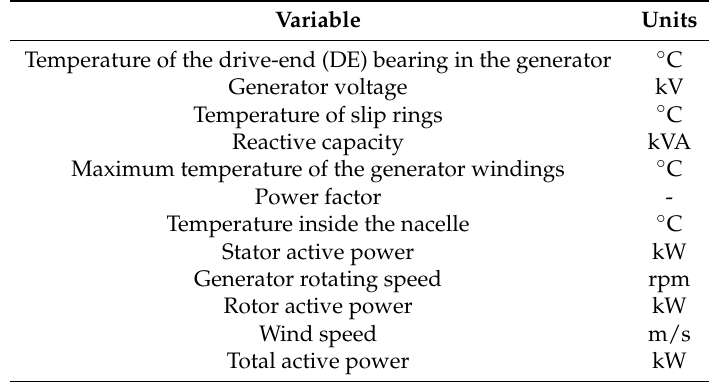
Table 1. Variables of the wind turbines considered for creating the temperature model of the NDE bearing ( ◦